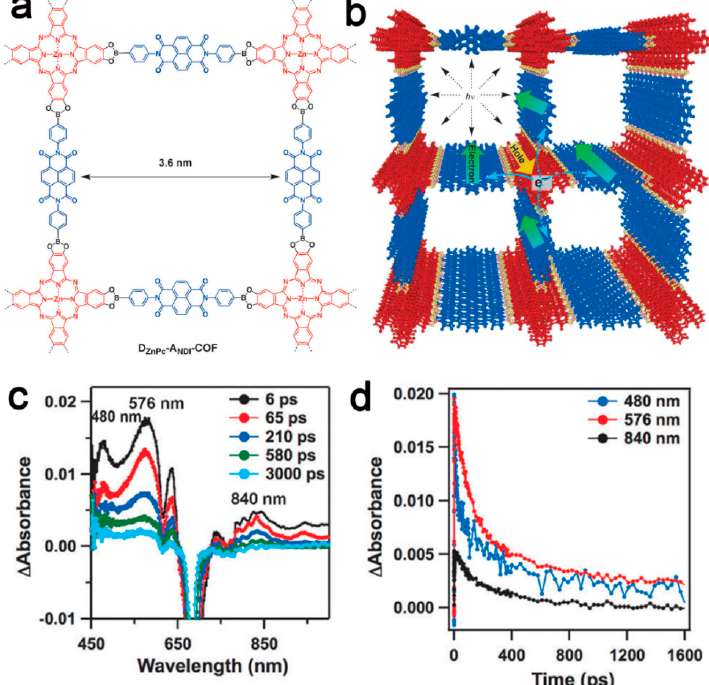
Figure 9. A structural illustration of the donor–acceptor covalent organic framework (COF) ( D ZnPc - A NDI COF ) ( a ); slipped stacking of D ZnPc -A NDI COF and the illustration of its electron transport ( b